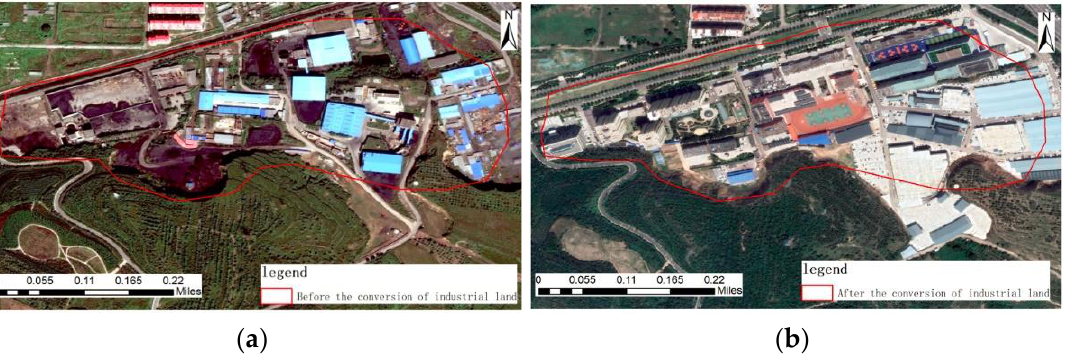
Figure 13. Remote sensing images before and after ecological restoration in an industrial land reconstruction area. ( a ) before treatment; ( b ) after treatment.